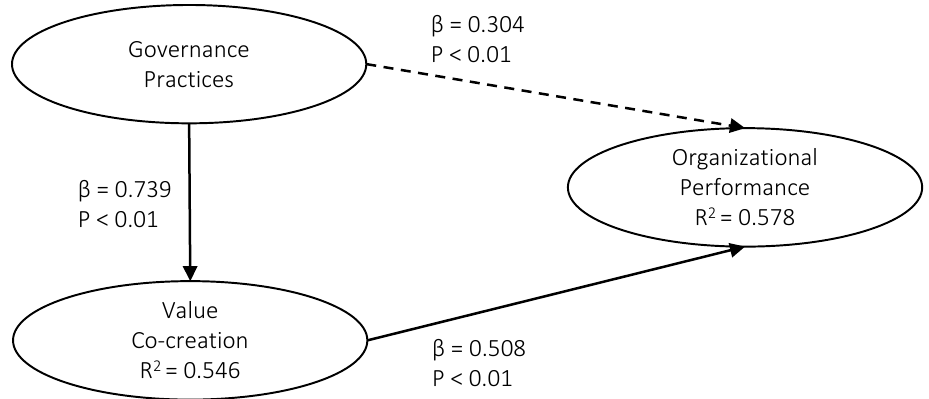
Figure 1. Path analysis